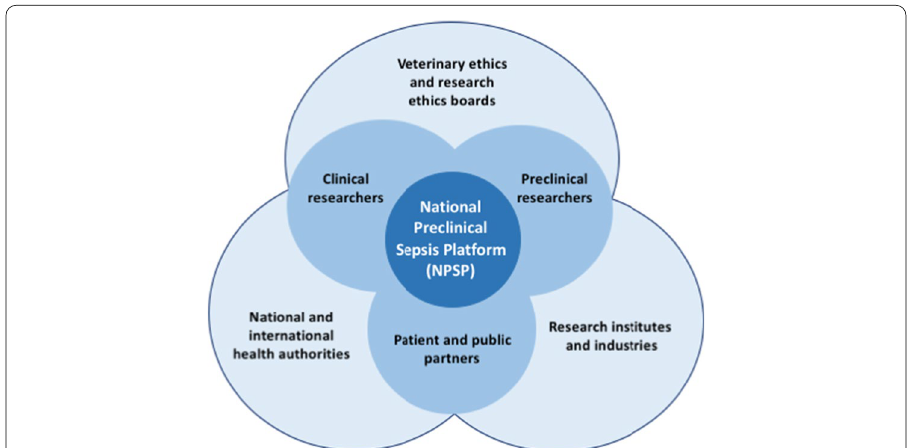
Fig. 1 An integrated knowledge translation (iKT) approach to preclinical research, as described for the National Preclinical Sepsis